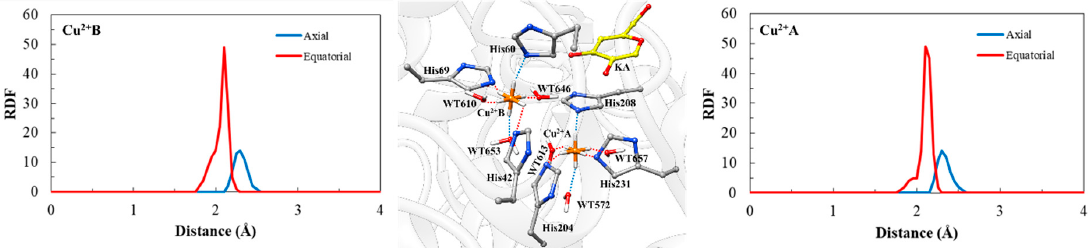
Figure 7. A representative snapshot of dummy models in TYR Bm -KA system taken from molecular dynamic (MD) simulations (on center). Radial distribution function around Cu 2+ A (right) and Cu 2+ B (left) for CuDum models into the catalytic site of TYR Bm -KA system. The enzyme portion is shown